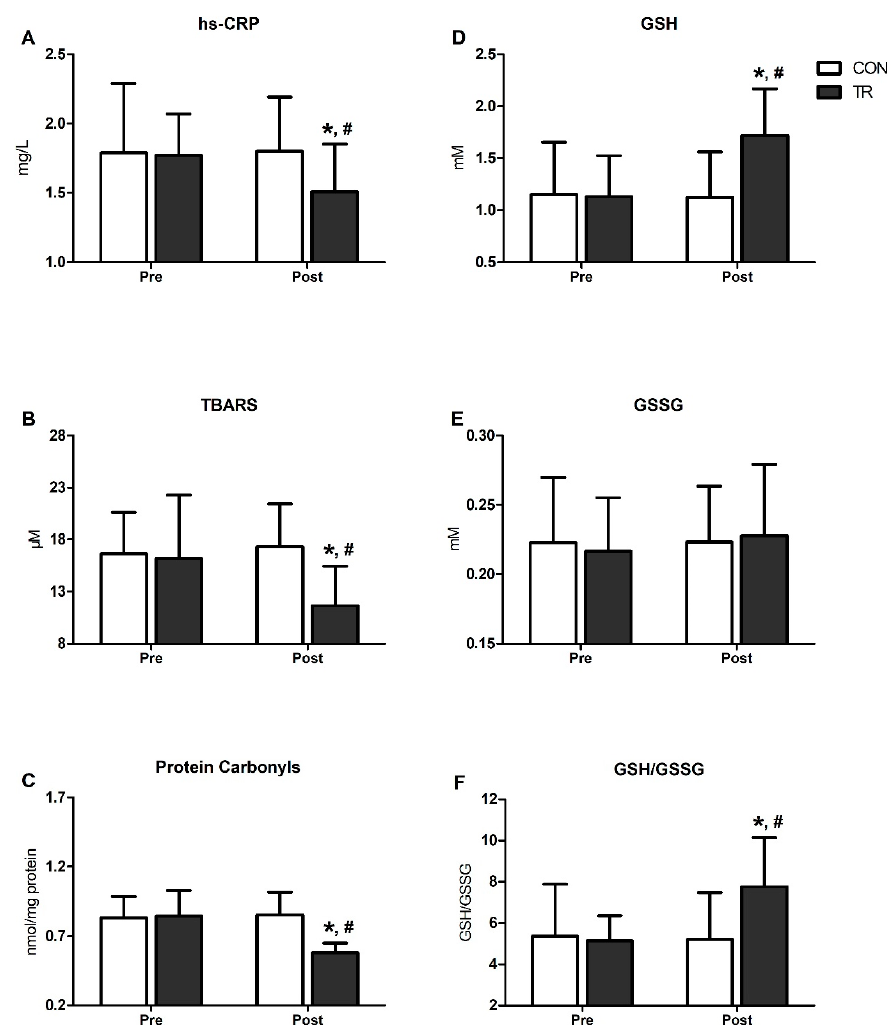
Figure 2. Six-month exercise training intervention reduced oxidative stress and systemic inflammation indices and improved blood redox status. Changes in high-sensitivity-CRP (hs-CRP) ( A ), thiobarbituric acid reactive substances (TBARS) ( B ), proteins carbonyls ( C ), reduced glutathione (GSH) ( D ), oxidized glutathione (GSSG) ( E ) and GSH/GSSG ration ( F ), in training group (TR) and control group (CON) after the 6-month intervention. Data are presented as mean ± standard deviation. *Significant difference with pre-training values ( p < 0.05); #Significant difference with the CON group ( p < 0.05).